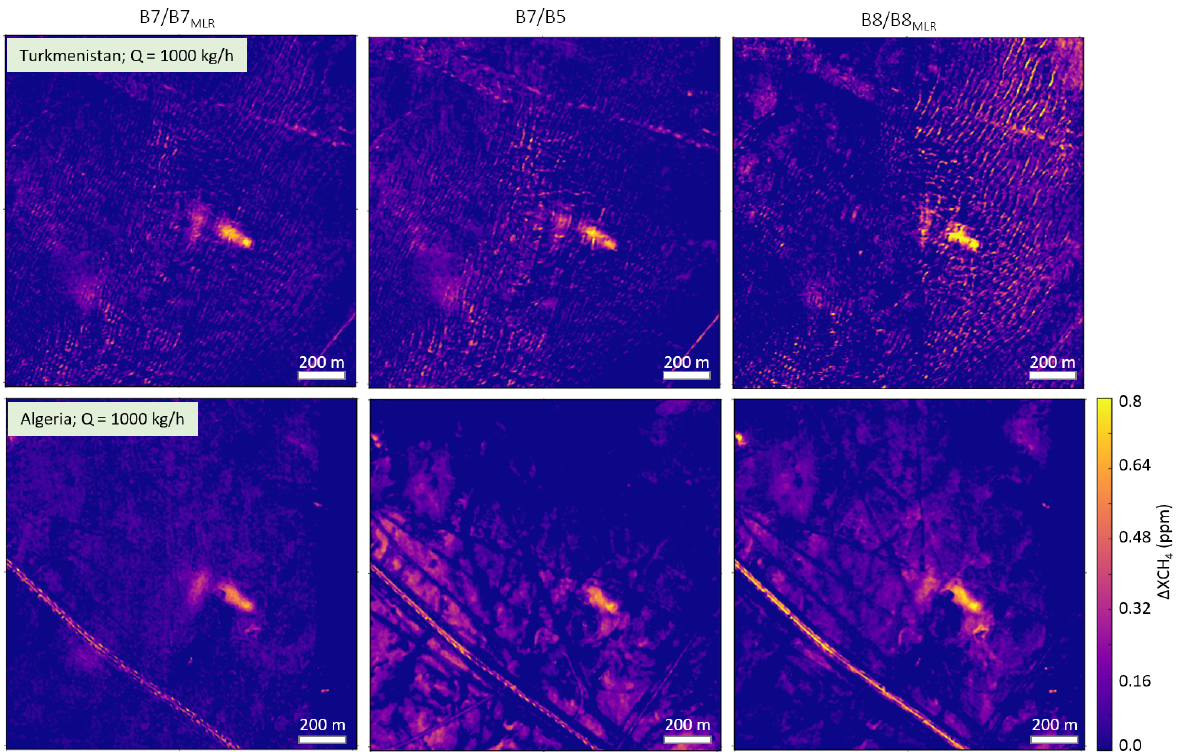
Figure 6. Comparison between different (cid:49) XCH 4 retrieved maps for the simulations at two sites (with the input plume of Q = 1000kgh − 1 in Fig. 4), and obtained by carrying out three different retrievals. From left to right: the ratio between B7 and B7 predicted (MLR with B1 to B6); the ratio between B7 and B5; and the ratio between B8 and B8 predicted (MLR with B1 to